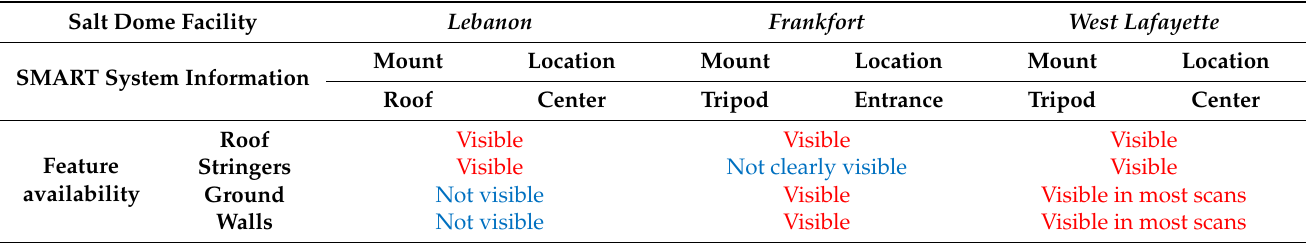
Table 2. Availability of registration features(shown in red) in the Lebanon , Frankfort , and West Lafayette datasets.